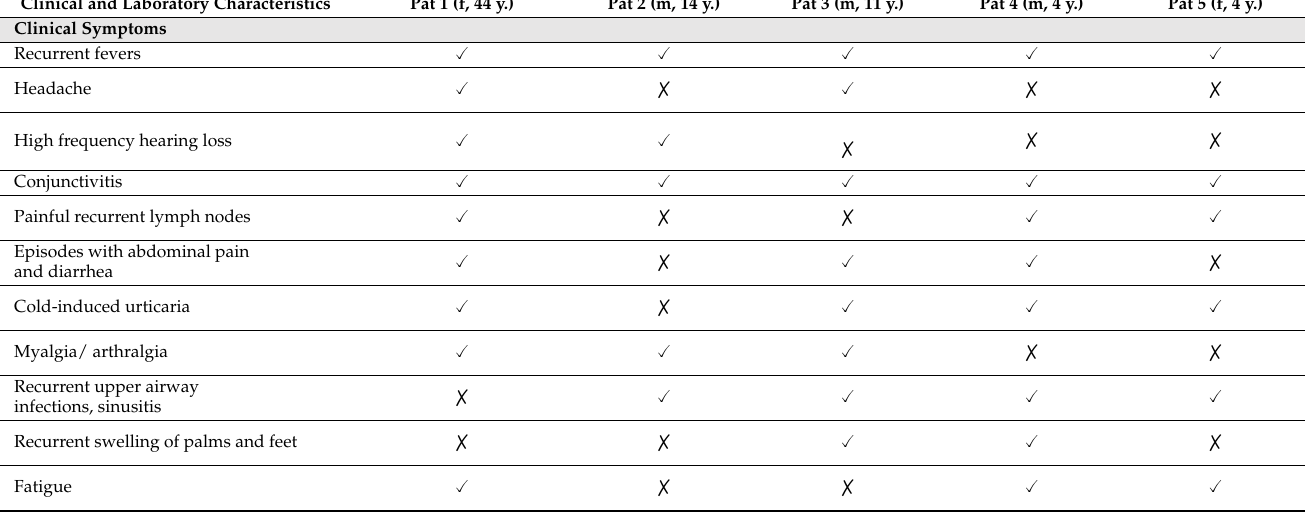
Table 1. Clinical and laboratory characteristics of patients with the heterozygous missense PLCG2 variant (c.77C>T, p.Thr26Met).